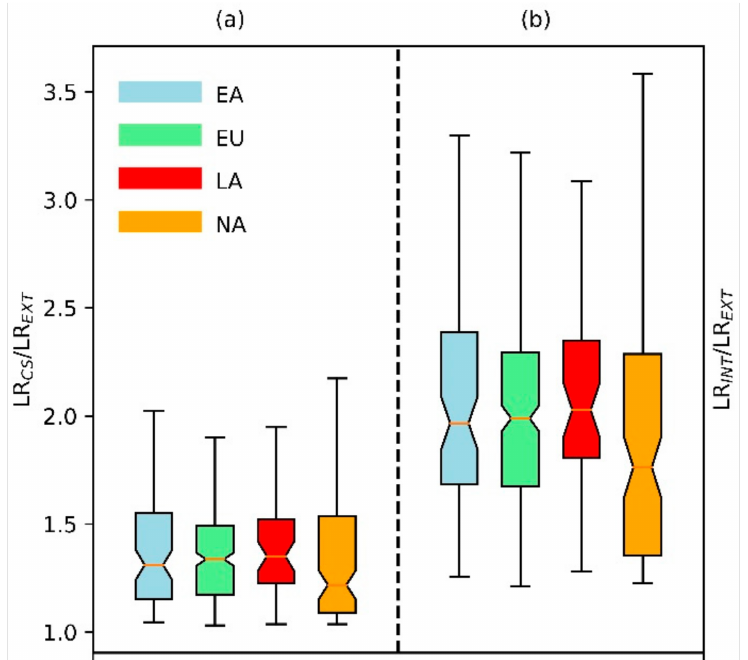
Figure 6. The ratio of the LR of ( a ) the core-shell mixing state to that of the external mixing state, ( b ) the homogeneously internal mixing state to that of the external mixing